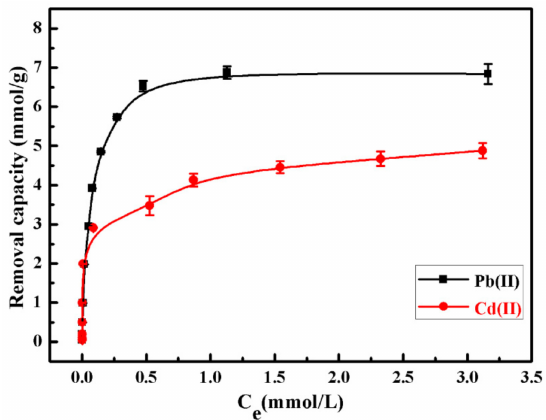
Figure 6. Removal capacities of the SiO 2 –Mg(OH) 2 nanocomposite for Pb(II) and Cd(II) at pH